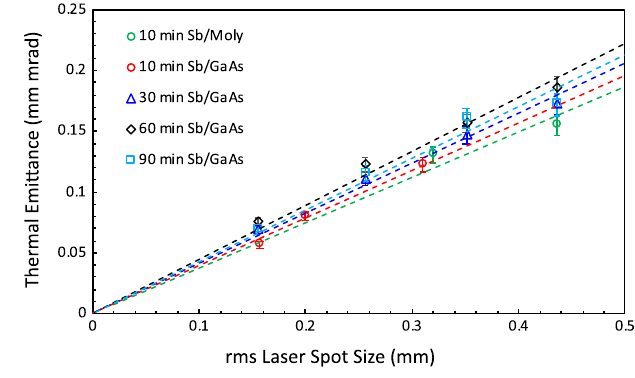
FIG. 8. Thermal emittance x , y geometric mean versus laser spot size ( σ